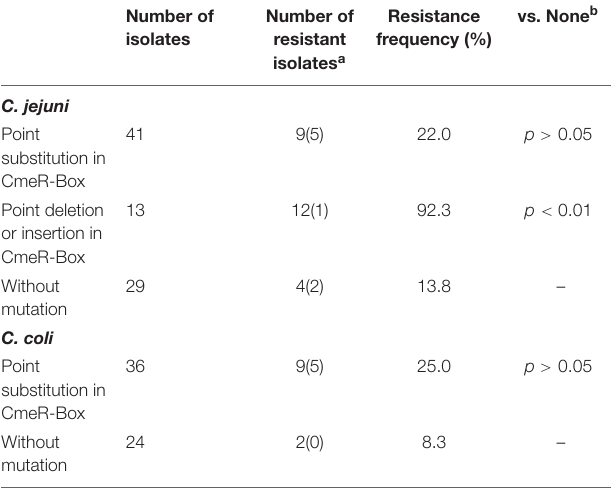
TABLE 2 | CmeR-Box polymorphisms in C. jejuni and C. coli